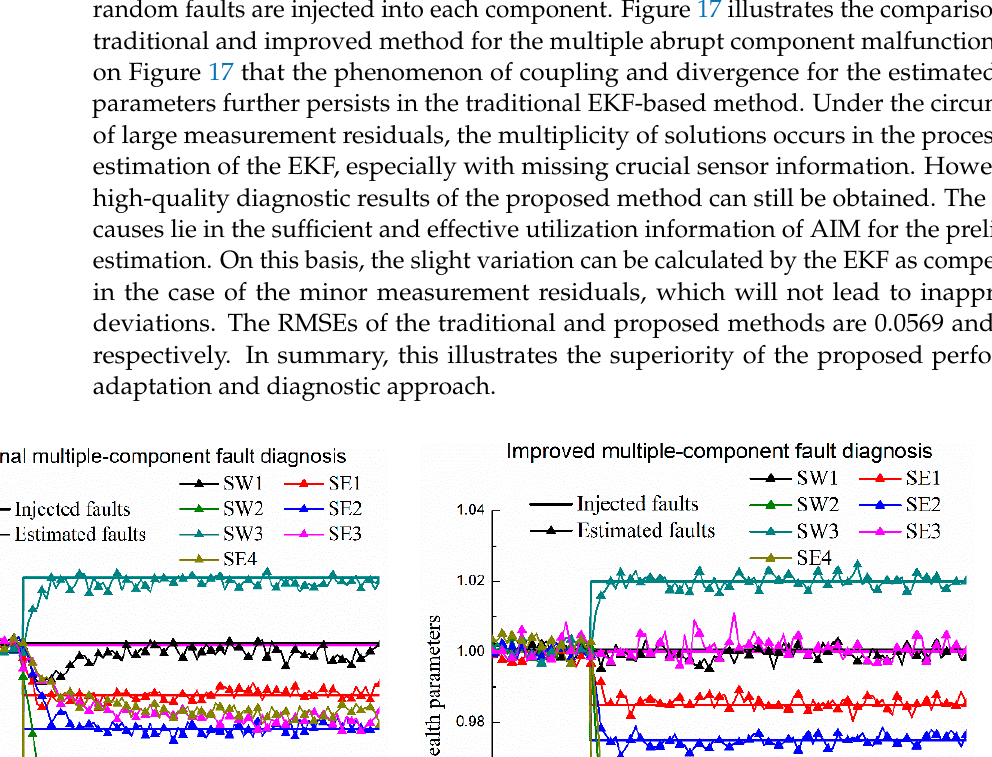
Figure 16. The local analysis of SW3 in Case 3.